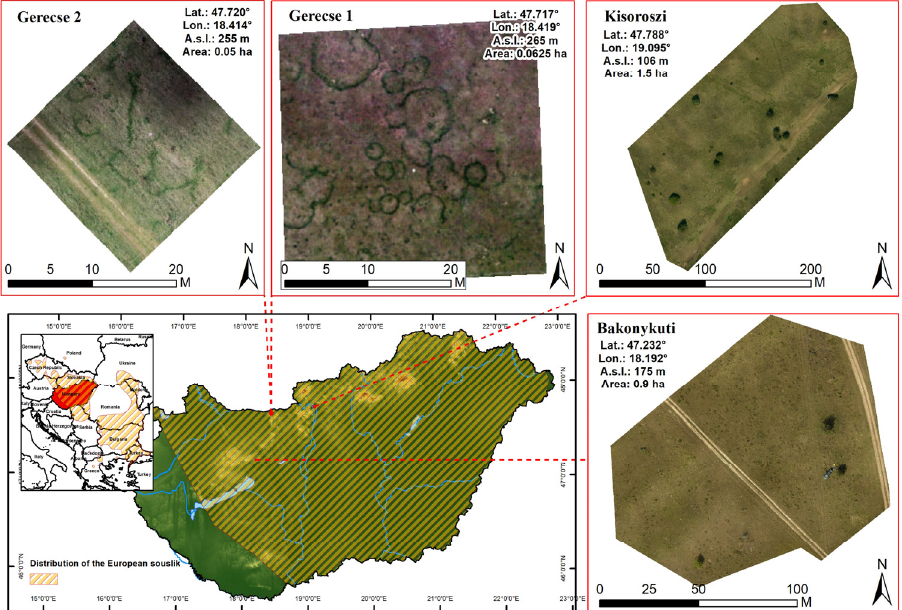
Figure 1. Location of studied souslik colonies in Hungary, and area and spatial position of images used for image processing.